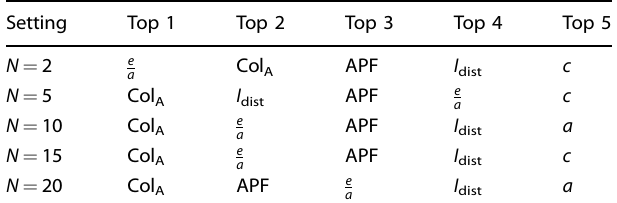
Table 3. The top 5 important factors selected by BMARS for